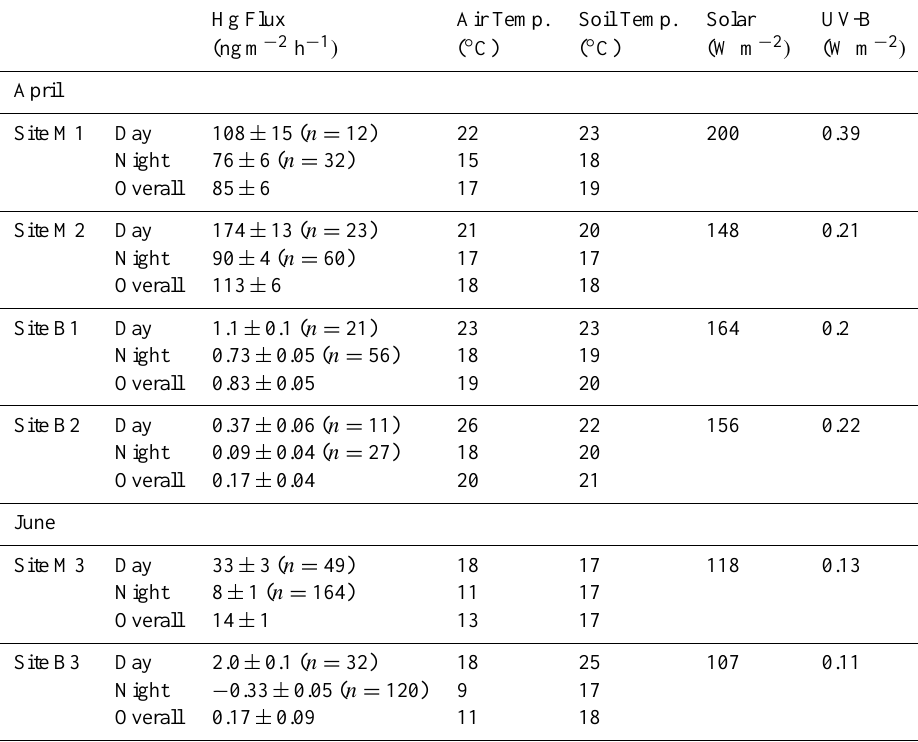
Table 2. Summary of GEM fluxes and environmental parameters measured over six locations at the Pulganbar site during the April and June field campaigns. Hg Flux Air Temp. Soil Temp. Solar